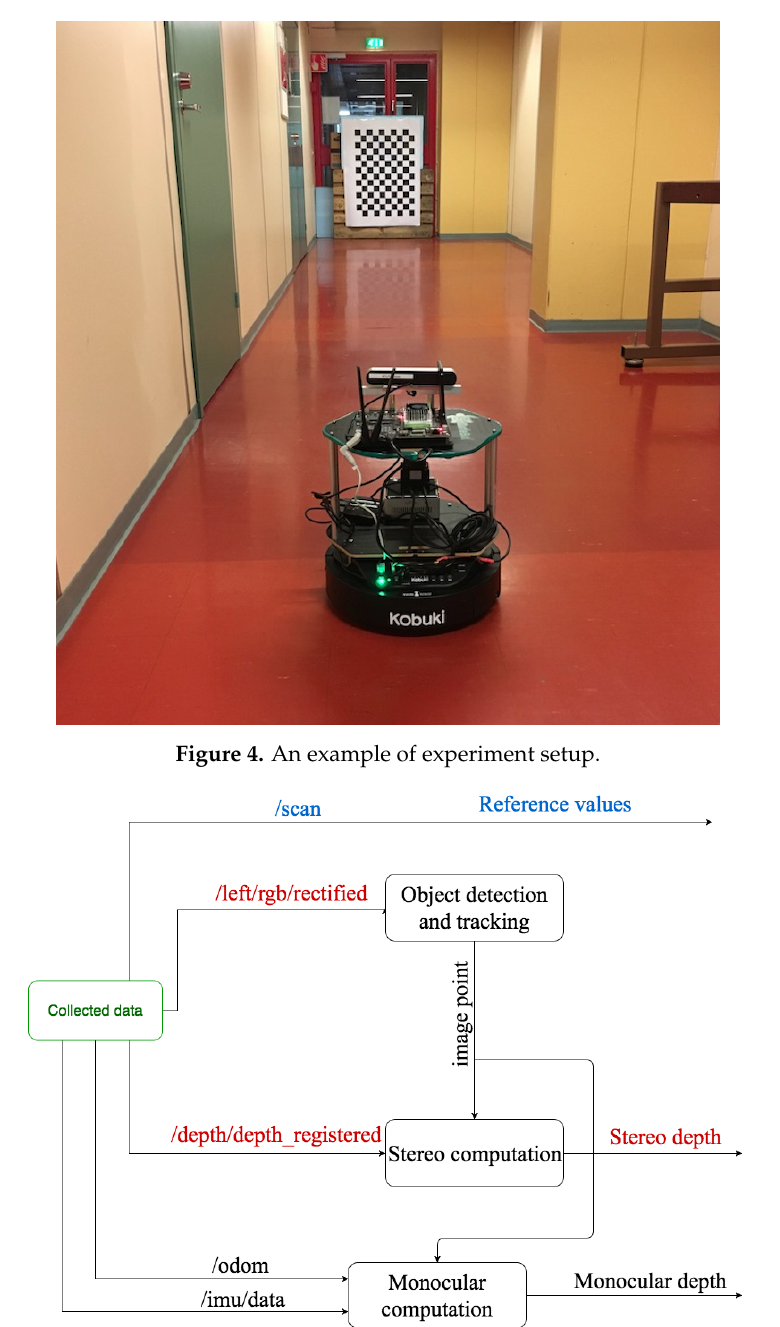
Figure 5. Data processing